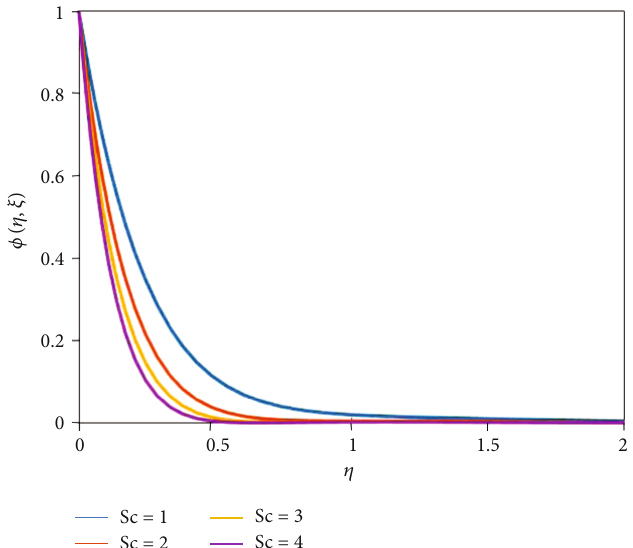
: 8, ξ = 1, N N Df = Bi = Sr = 0 : 5, He b = t = w = 0